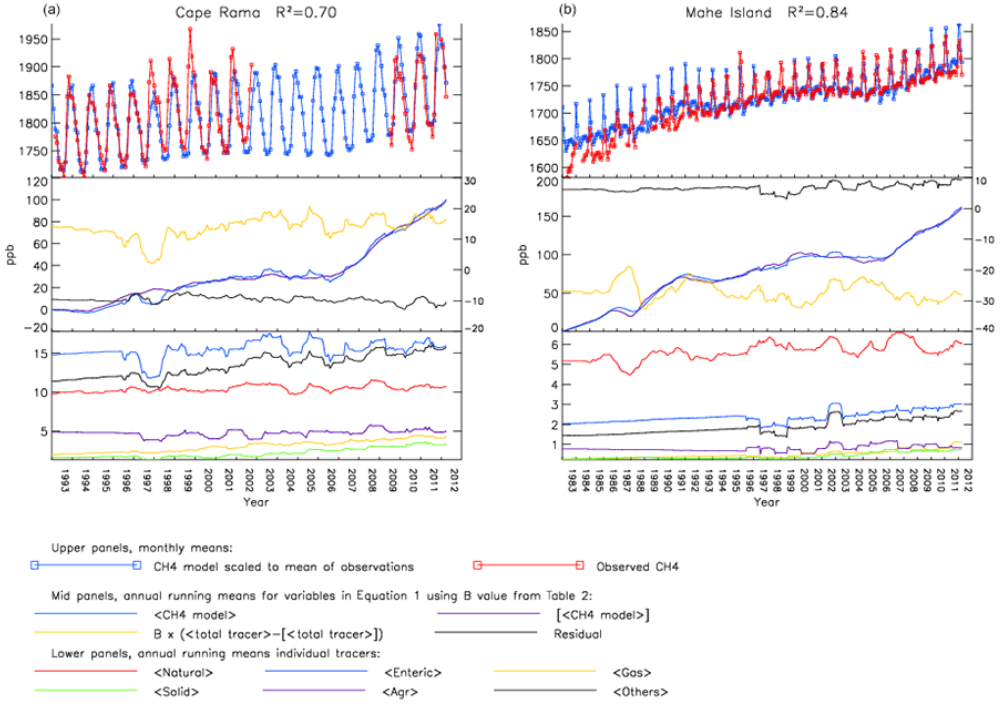
Figure 10. Evolution of CH 4 and tracers at stations ( a : Cape Rama, b : Mahe Island) in background/outflowing air in or near Asia. See Fig. 6 caption for further